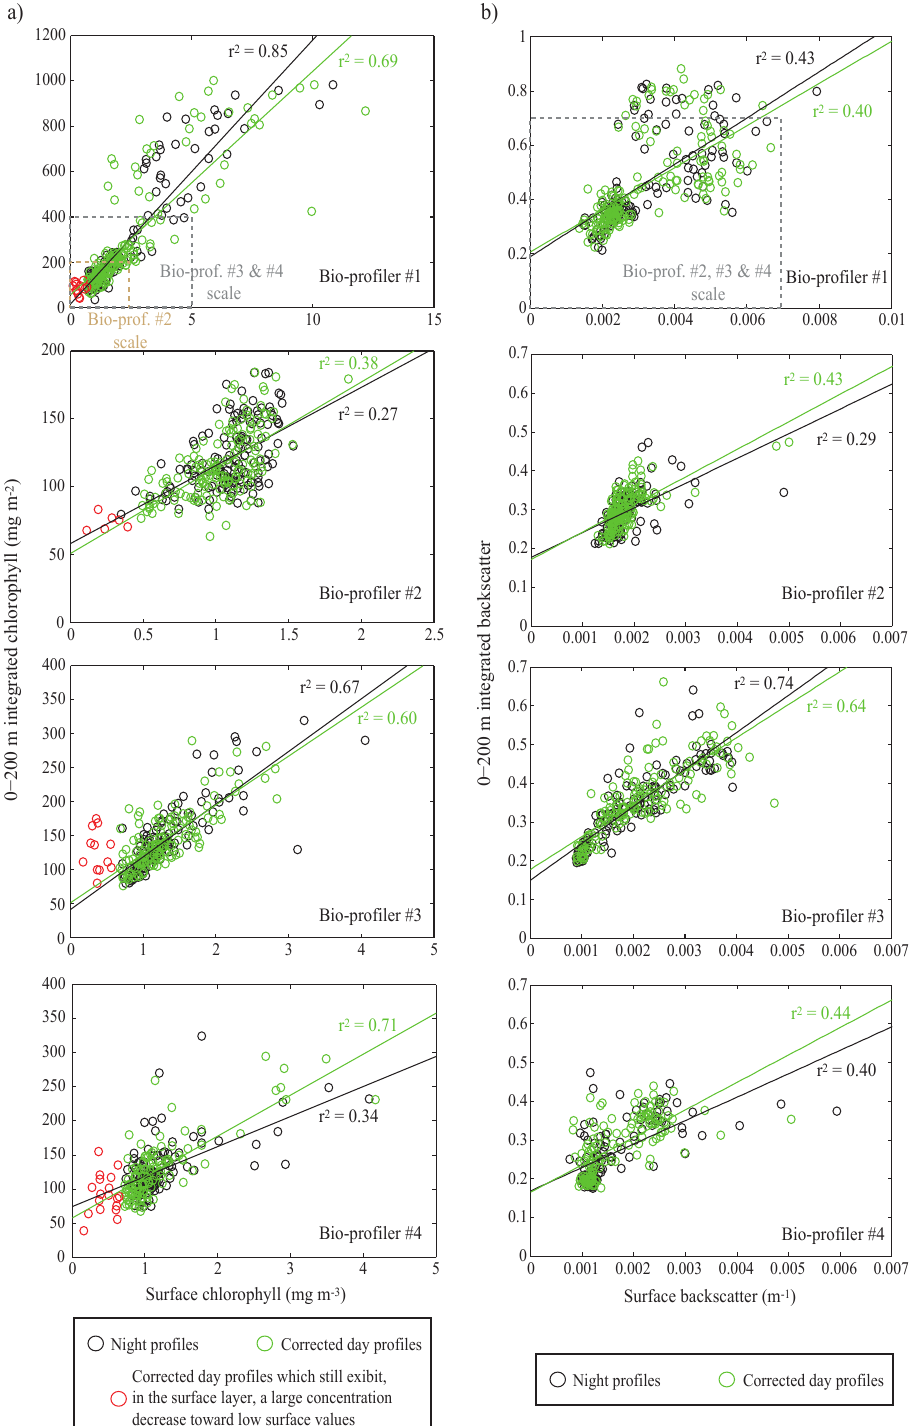
Figure 8. (a) Surface chlorophyll concentrations (in mgm − 3 ) compared to chlorophyll inventories (0–200m; in mgm − 2 ) , for each bio- profiler. (b) Surface particulate backscattering (m − 1 ) compared to particulate backscattering inventories (0–200m), for each bio-profiler. Note that scales are slightly larger for bio-profiler #1 than for the others; the dashed rectangles in upper plots indicate the scales used for the other bio-profilers. Night profiles (black circles), day profiles (green circles), and potentially quenching under-corrected day profiles (red circles, flagged as defined in the caption of Fig. 2b) are distinguished. Correspondingly, the green and black lines refer to the linear regression of day and night profiles and their associated correlation coefficients, r 2